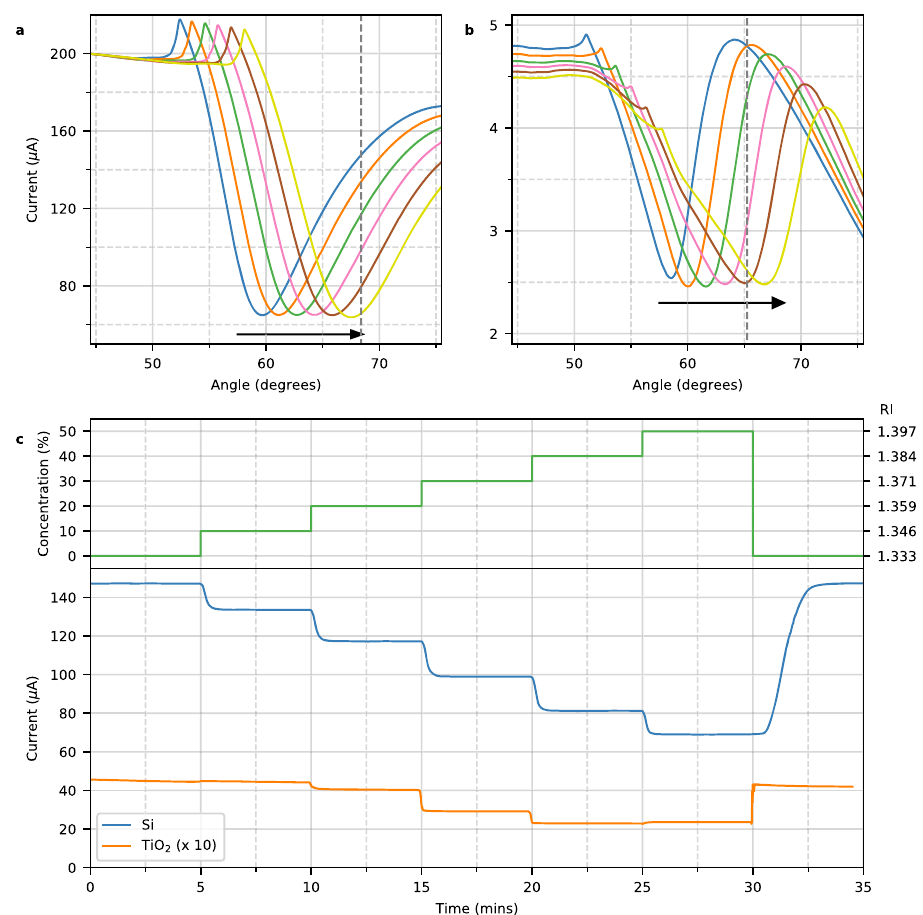
Fig. 3 Refractive Index sensing. a , b Photocurrent as a function of angle in solutions of different glycerol concentration [0%, 10%, 20%, 30%, 40%, 50%] with RI = 1.333, 1.346, 1.359, 1.371, 1.384, 1.397 for silicon sample a and TiO 2 sample b . c Photocurrent as a function of time for changing glycerol concentration at the fi xed angles indicated by the dashed lines in a , b for Si (blue) and TiO 2 (orange). The TiO 2 data is multiplied by a factor of 10 for clarity. The upper panel (green) indicates the corresponding glycerol concentration (left axis) and RI (right axis) of the solution. Source data are provided as a Source Data fi